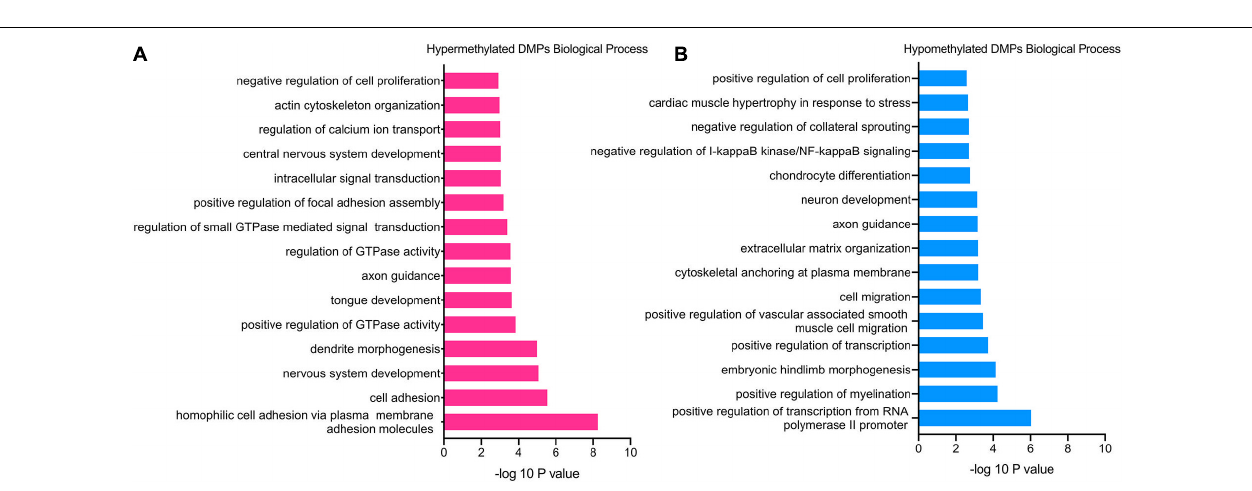
FIGURE 3 | GO enrichment analysis of TAO-associated DMPs. (A) Top 15 most significant biological process (BP) terms of hypermethylated DMPs. (B) Top 15 most significant biological process (BP) terms of hypomethylated DMPs.